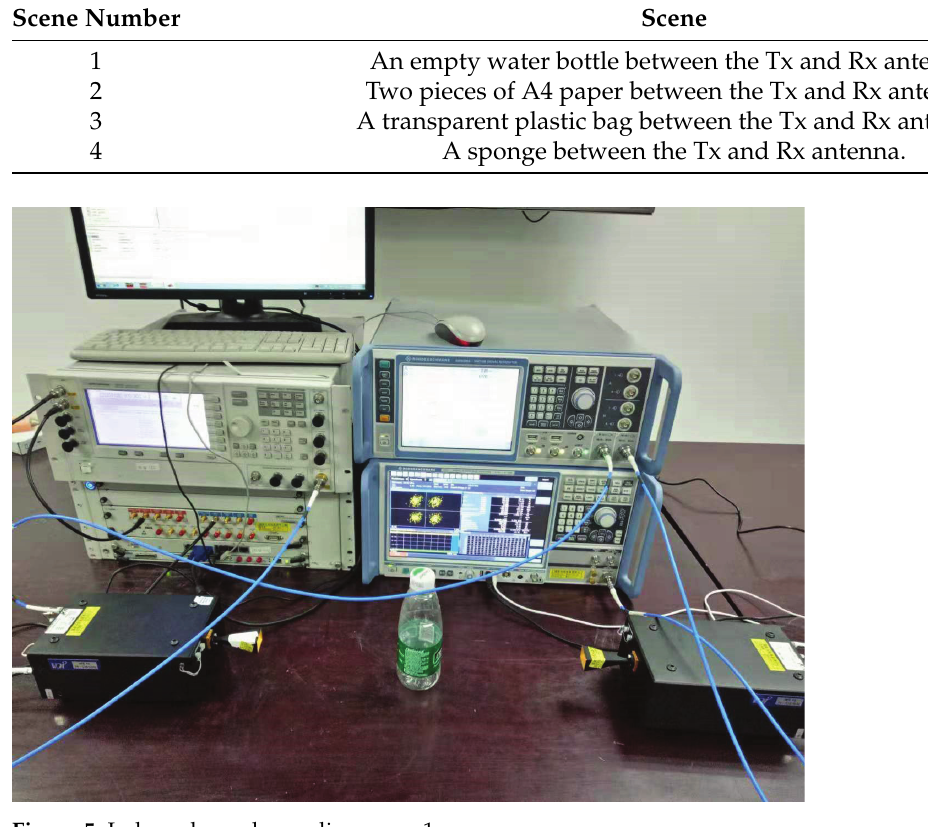
Figure 5. Indoor channel sounding scene 1.